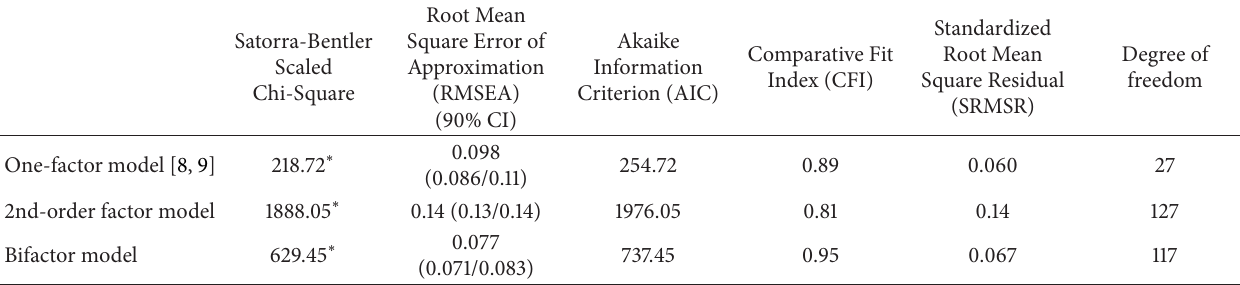
Table 2: Fit statistics for the concurrent models (estimator: Robust Diagonally Weighted Least Squares).